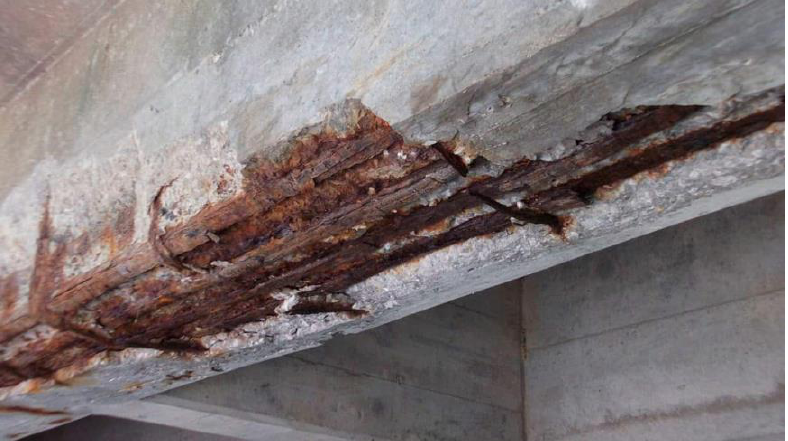
Figure 1. Structural performance deterioration of a reinforced concrete (RC) structure due to rein- forcement corrosion.